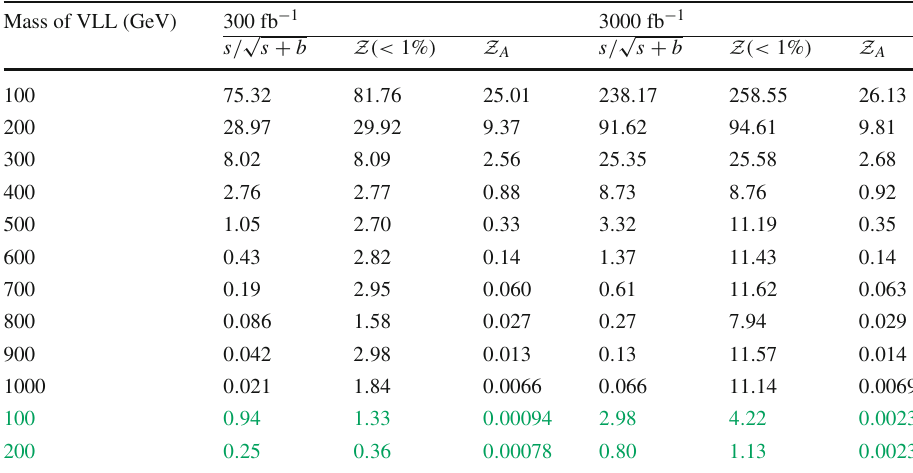
Table 5 Signal significance for VLL single-production at the LHC calculated with an evolution algorithm that maximises the Asimov metric. The last two rows represent the singlet model whereas the remaining ten are benchmark points of the doublet model. The colour coding is the same as in Eqs. (14) and (15)